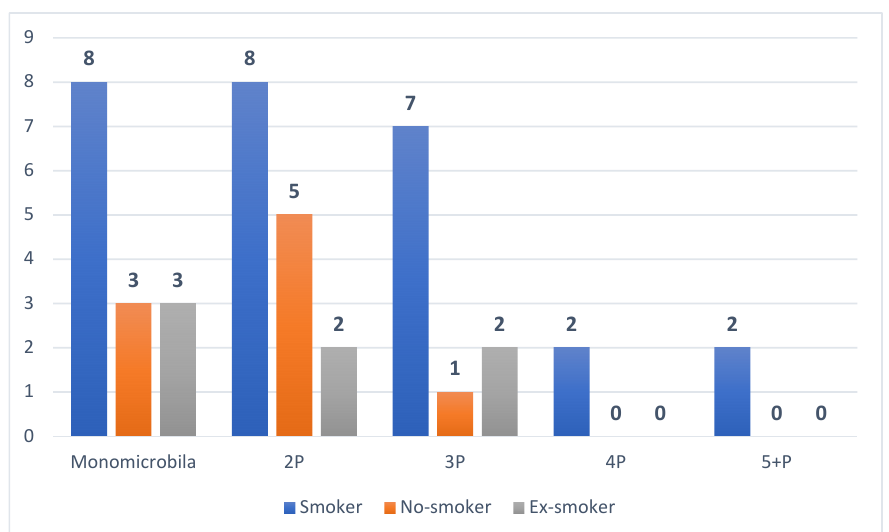
Figure 2. Monomicrobial and polymicrobial infections and DFU patient lifestyle: cigarette smoking. P2: polymicrobial infection colonized by 2 microorganisms; P3: polymicrobial infection colonized by 3 microorganisms; P4: polymicrobial infection colonized by 4 microorganisms; P5+: polymicrobial infection colonized by 5 or more microorganisms.